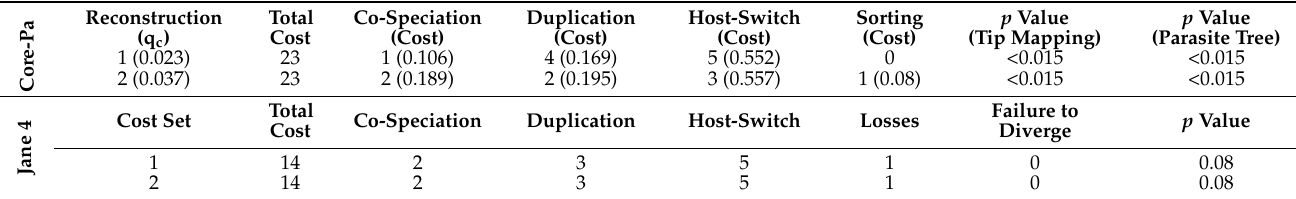
Table 3. Results of reconciliation analyses for VSBV-1 and its hosts using CoRe-Pa and Jane 4. Reconstruction (q c P a e - o r C